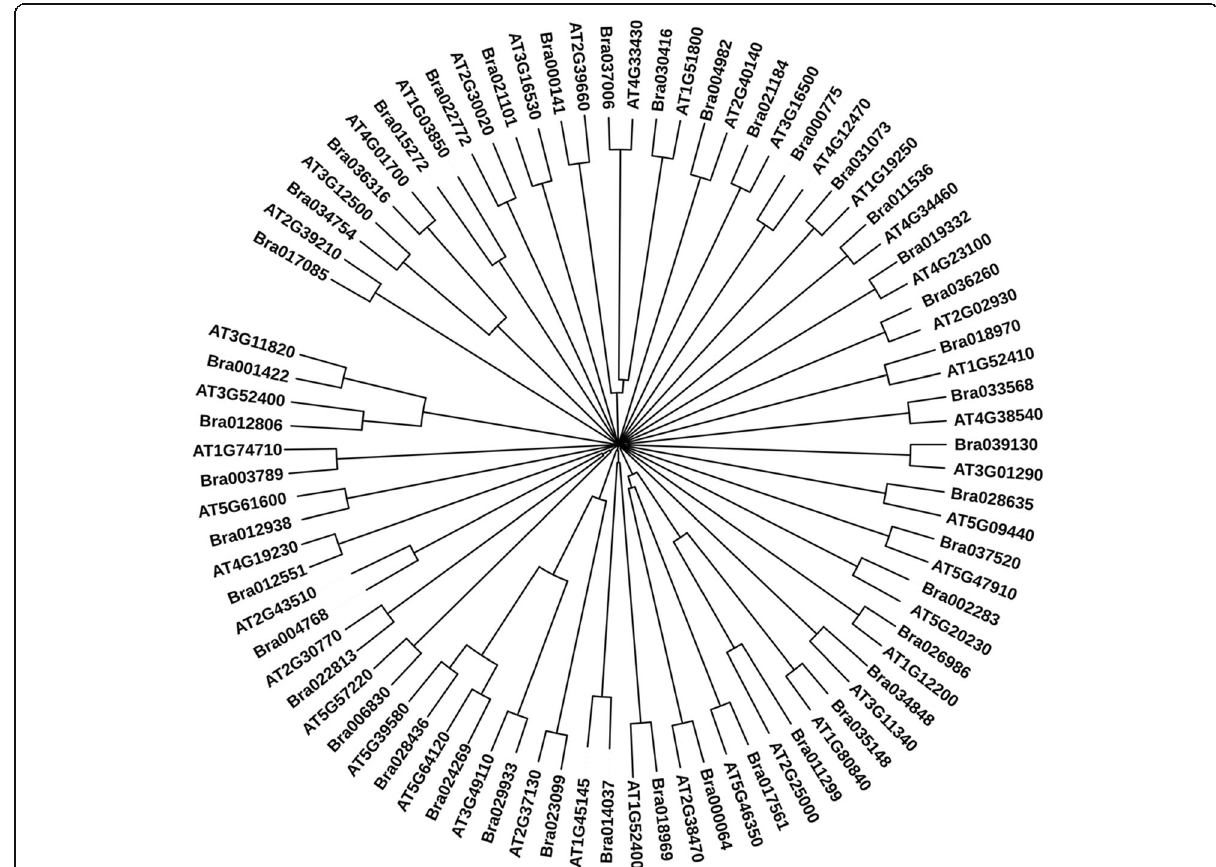
Fig. 6 Neighbor-Joining tree was constructed to determine the relationship among Arabidopsis and Brassica sequences involved in defense response against fungi extracted from contrast ETMC and BrGDB